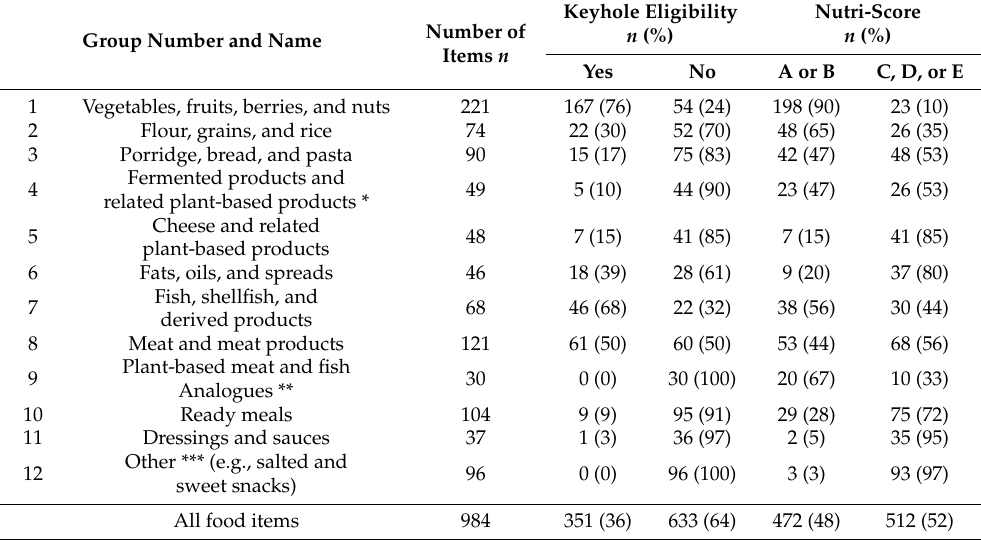
Table 3. The number of food items included in the assessment and the corresponding Keyhole eligibility and Nutri-Score, separated by group according to the Keyhole criteria (LIVSFS